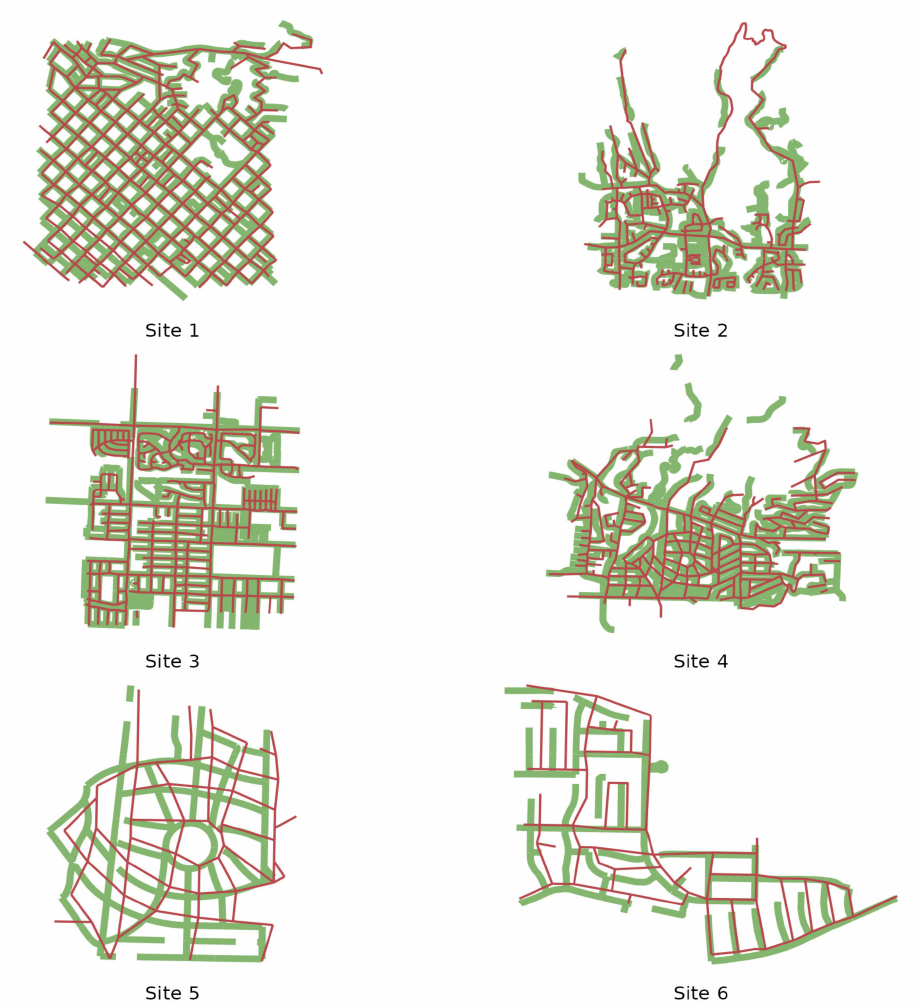
Figure 3. Test data at six sites in Santa Barbara County, CA, from OSM (green) and TIGER (red),